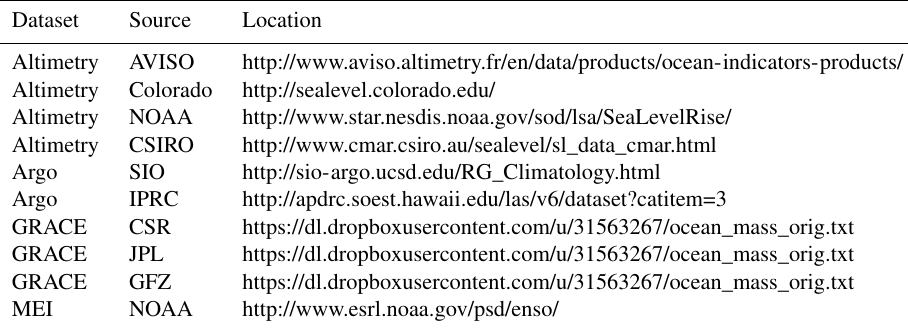
Table E1. Locations and sources of the data used here. Websites accessible as of 2 June